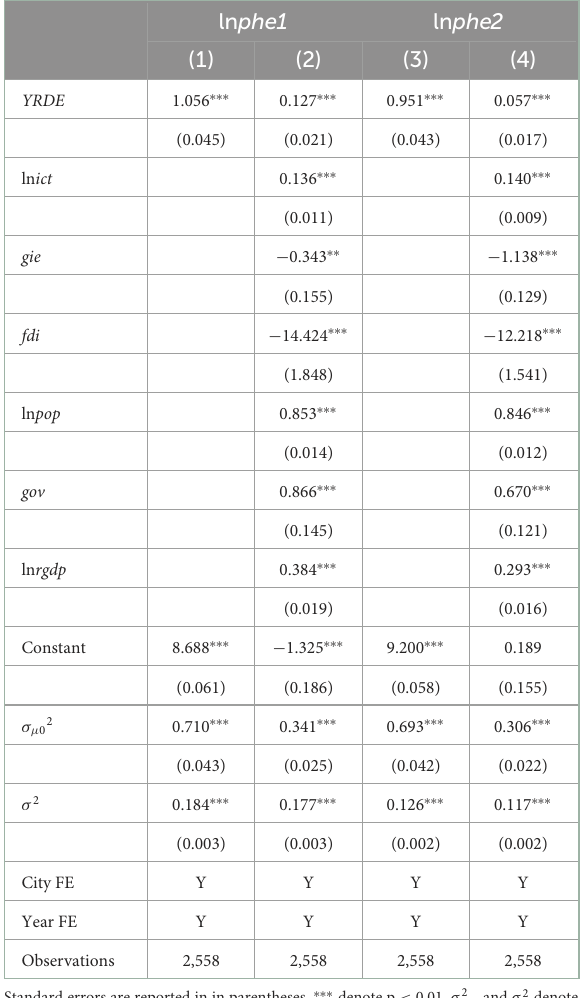
TABLE 7 Endogeneity test based on DID